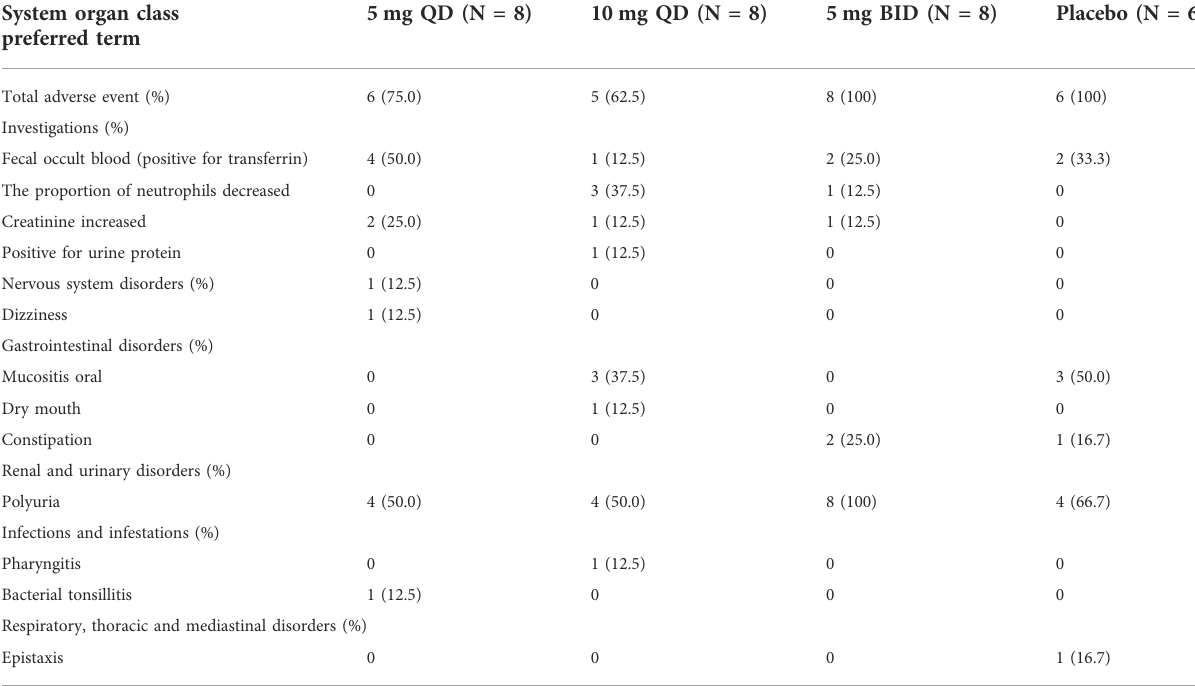
TABLE 5 Summary of adverse events at each dose level in the multiple-dose